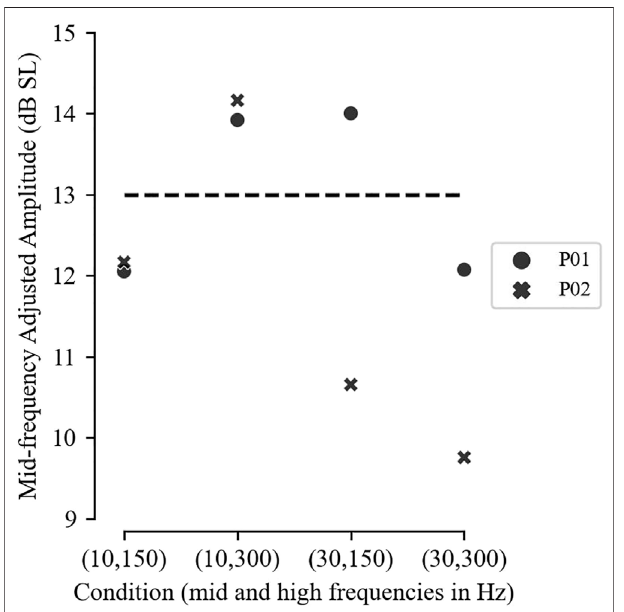
FIGURE 7 | Sensitivity index d ′ values from pairwise comparison in Exp. 2. The horizontal line indicates the performance criterion for discrimination at d ′ =